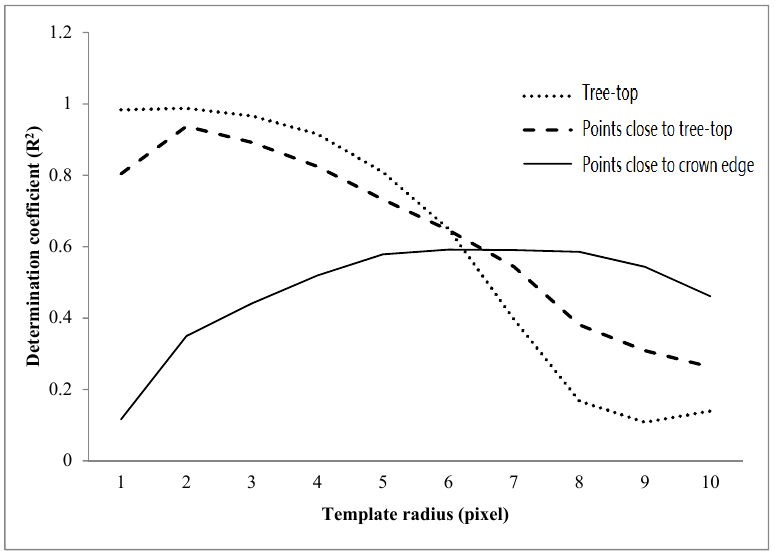
Figure 3. The determination coefficient trend variance of correlation with the treetop and crown for different radius with cosine function.